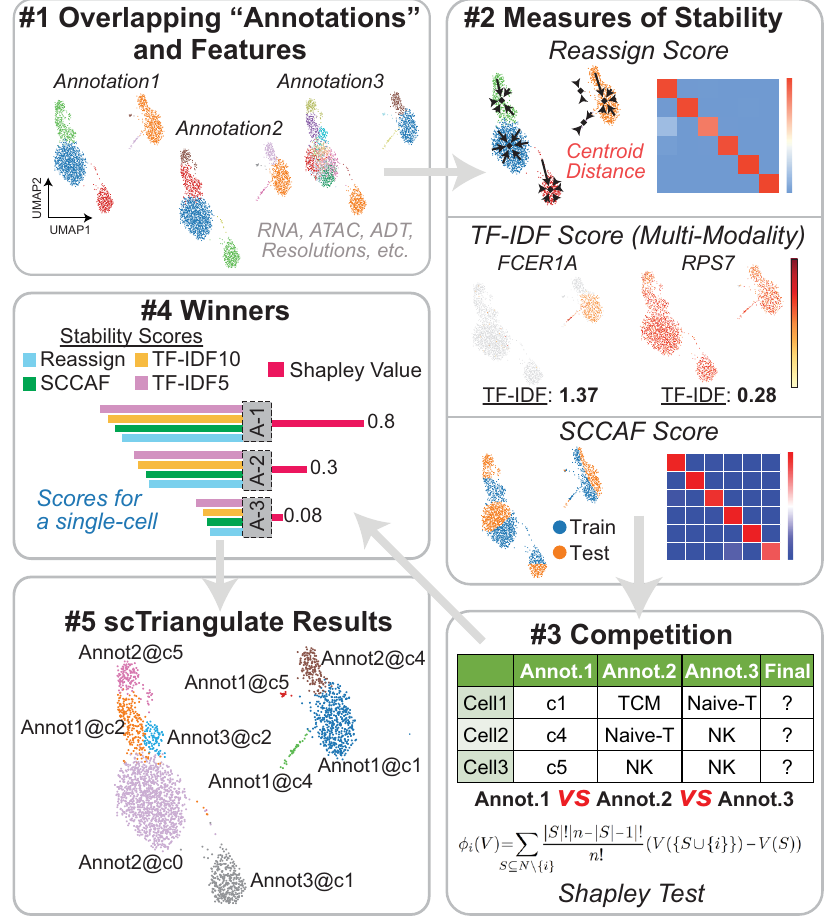
Fig. 1 | Resolving con fl icting cluster identities from decision-level integration. Overview of scTriangulate. Using multiple competing annotation sources (algo- rithm,modality,andresolution),differentstatisticalstabilitymetricsarecomputed foreachclusterandcell.Eachcellisassignedtothewinningclusterlabelbasedona computed importance score (Shapley or Rank) (Steps 1 – 5, Methods). The reassign